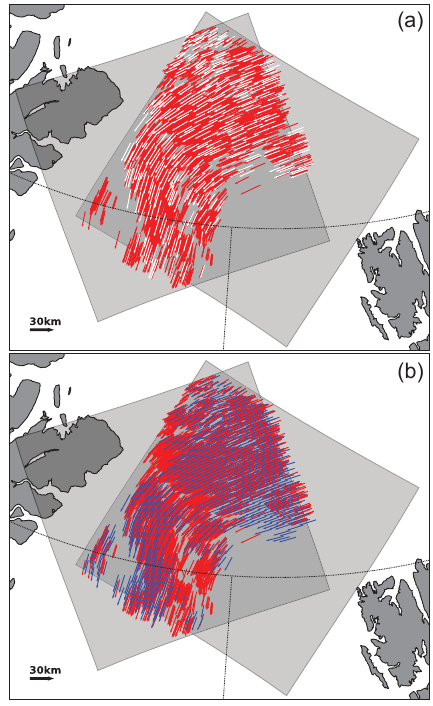
Figure 5. Sea ice drift of the Sentinel-1 image pair Fram Strait (Ta- ble 1). (a) Manually drawn vectors are shown in white and the com- puted ORB vectors in red. (b) shows ORB vectors in comparison to the drift vectors from the CMEMS/DTU data